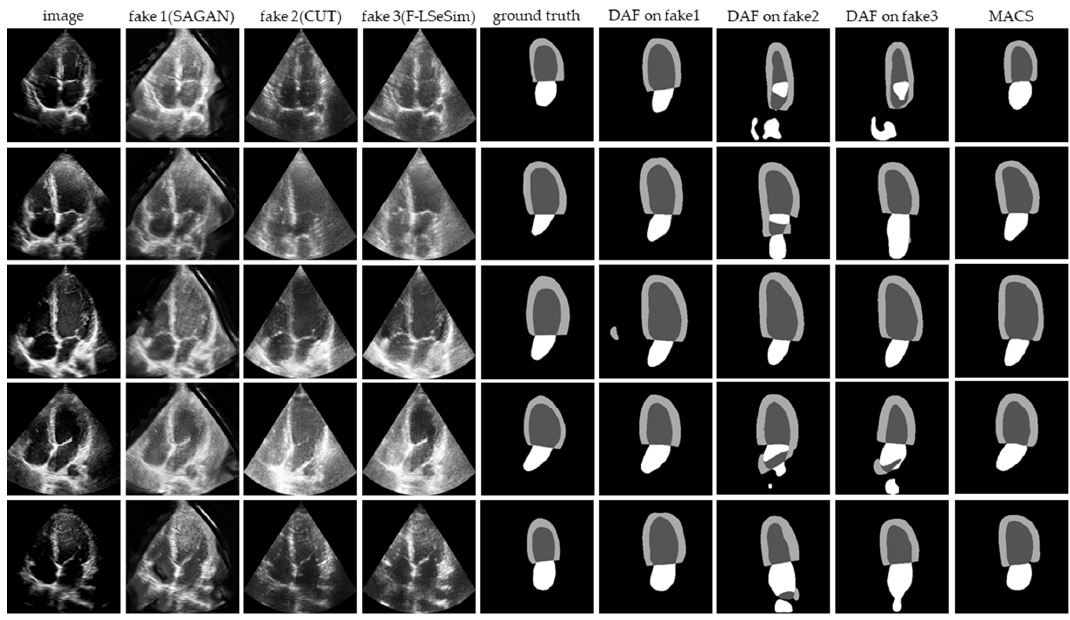
Figure 6. Fake images generated by image-to-image translation methods (SAGAN, CUT, F-LSaSim) and the visualization prediction of fake images that segmented by the DAF. Table 3. Comparison with the segmentation performance on images translated by the SAGAN, F- LSeSim and CUT. The up arrow indicates expecting a higher value.